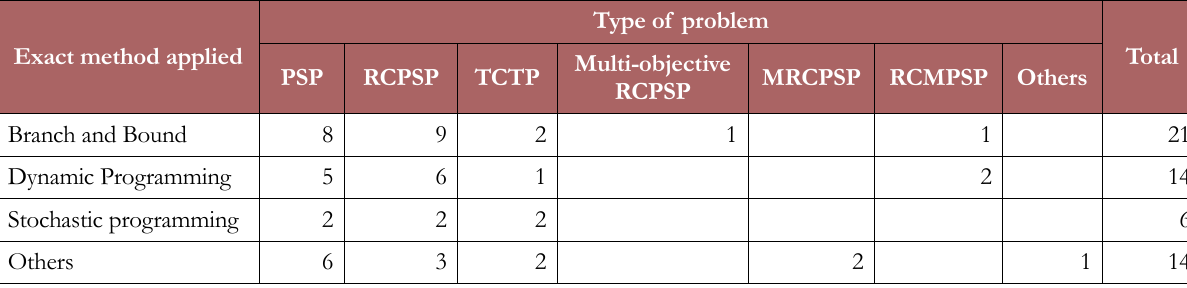
Table 7. Exact methods